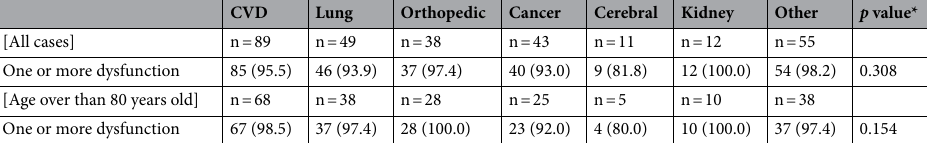
Table 2. Prevalence of dysfunction and overlapping of dysfunctions according to the primary disease. *Statistically significant (p < 0.05). CVD, cardiovascular disease.